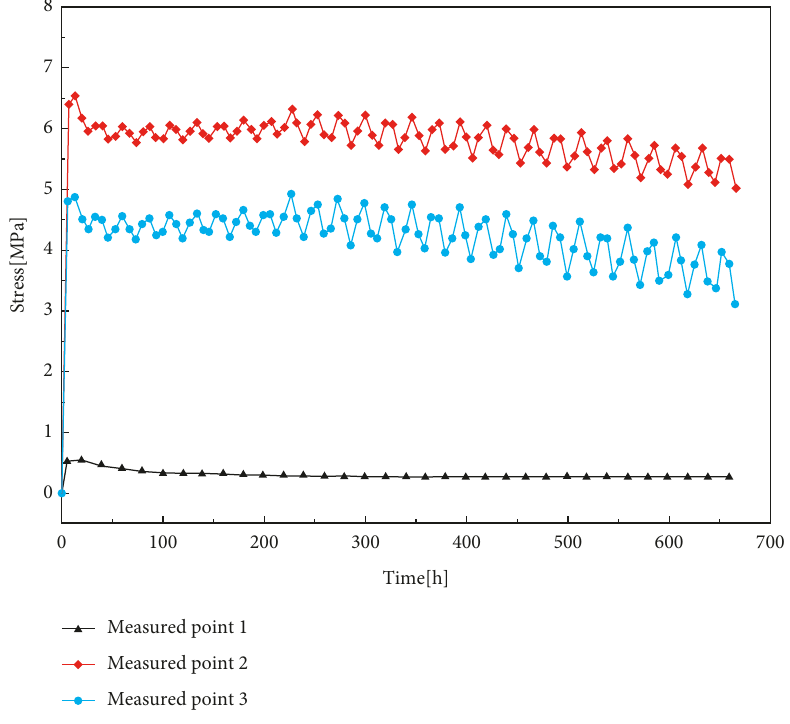
Figure 13: Time-temperature stress